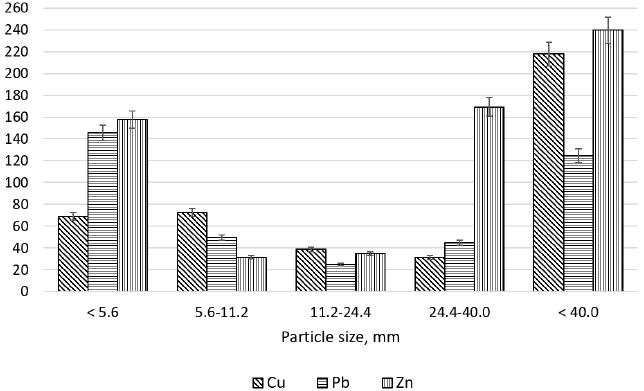
Figure 6. Concentrations of heavy metals in the different fractions of untreated bottom ash eluate.